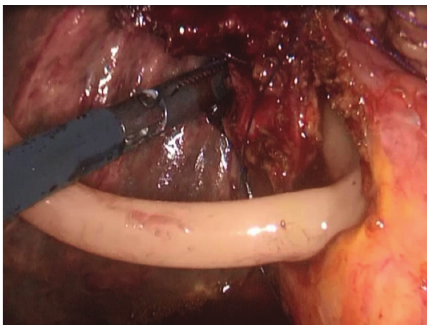
Figure 3: Placed T-tube drainage into the choledochus through the opening after stone extraction and irrigation of choledochus.